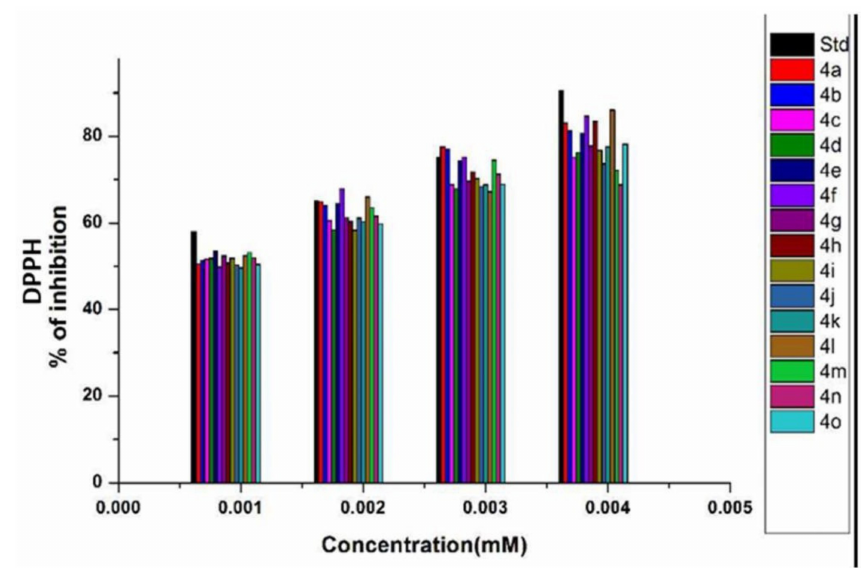
Figure 11. DPPH activity of the synthesized